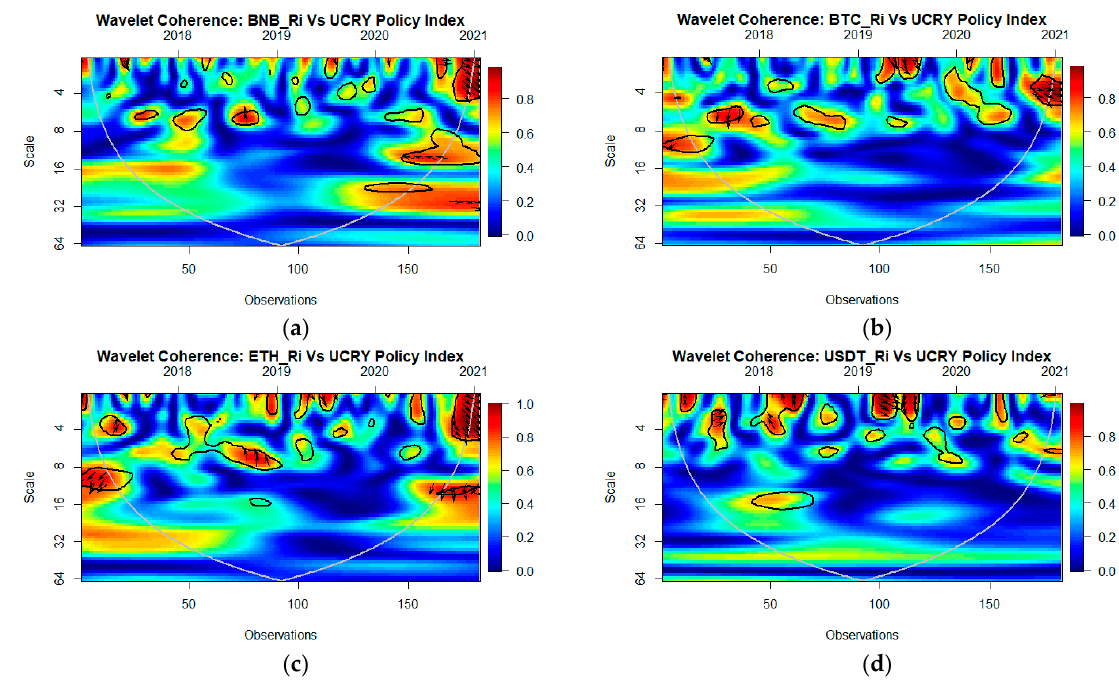
Figure 2. Wavelet coherence between conventional cryptos and UCRY policy index. Note: ( a ) = wavelet coherence between Binance Coin and UCYR Policy Index, ( b ) = wavelet coherence between Bitcoin and UCYR Policy Index, ( c ) = wavelet coherence between Ethereum and UCYR Policy Index, ( d ) = wavelet coherence between Tether and UCYR Policy Index.